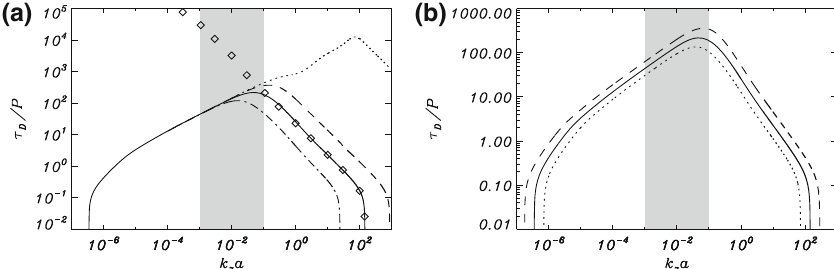
Fig. 73 Wave damping by ion-neutral effects in an infinitely long cylindrical prominence thread. Ratio of the damping time to the period of the kink mode as a function of k z a for a thread without transitional layer, i.e., l / a = 0. a Results for a = 100 km and different ionisation degrees: ˜ μ p = 0 . 5 (dotted line), ˜ μ p = 0 . 6 (dashed line), ˜ μ p = 0 . 8 (solid line) and ˜ μ p = 0 . 95 (dash-dotted line). Symbols are the approximate solution, given by Eq. (40), for ˜ μ p = 0 . 8. b Results for ˜ μ p = 0 . 8 and different thread widths: a = 100 km (solid line), a = 50 km (dotted line) and a = 200 km (dashed line). The shaded zone corresponds to the range of typically observed wavelengths of prominence oscillations. Image reproduced with permission from Soler et al. (2009d), copyright by